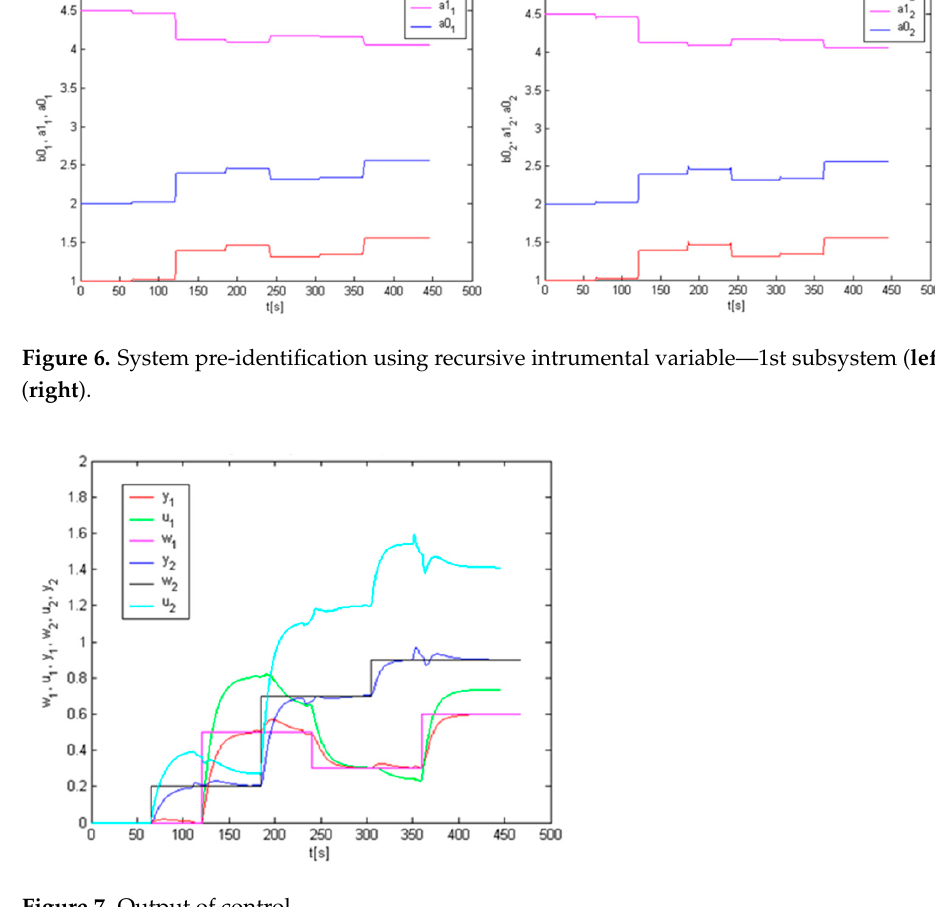
Figure 8. Controllers parameters during simulation—1st ( left ), 2nd ( right ) . 5.2. Results in Real-Time at Laboratory Model We verified the presented method in real-time control using MATLAB at CE108 Cou- pled Drives Apparatus Model [26] which is shown in the Figure 9. The laboratory model CE108 allows solving practical problems of tensioning and speed of material movement in continuous processes. An example is the speed and tension of the thread when rewind- ing from one spool to another, which must be controlled. This situation is adapted for laboratory measurements so that the elastic band is mounted on three wheels. The lower